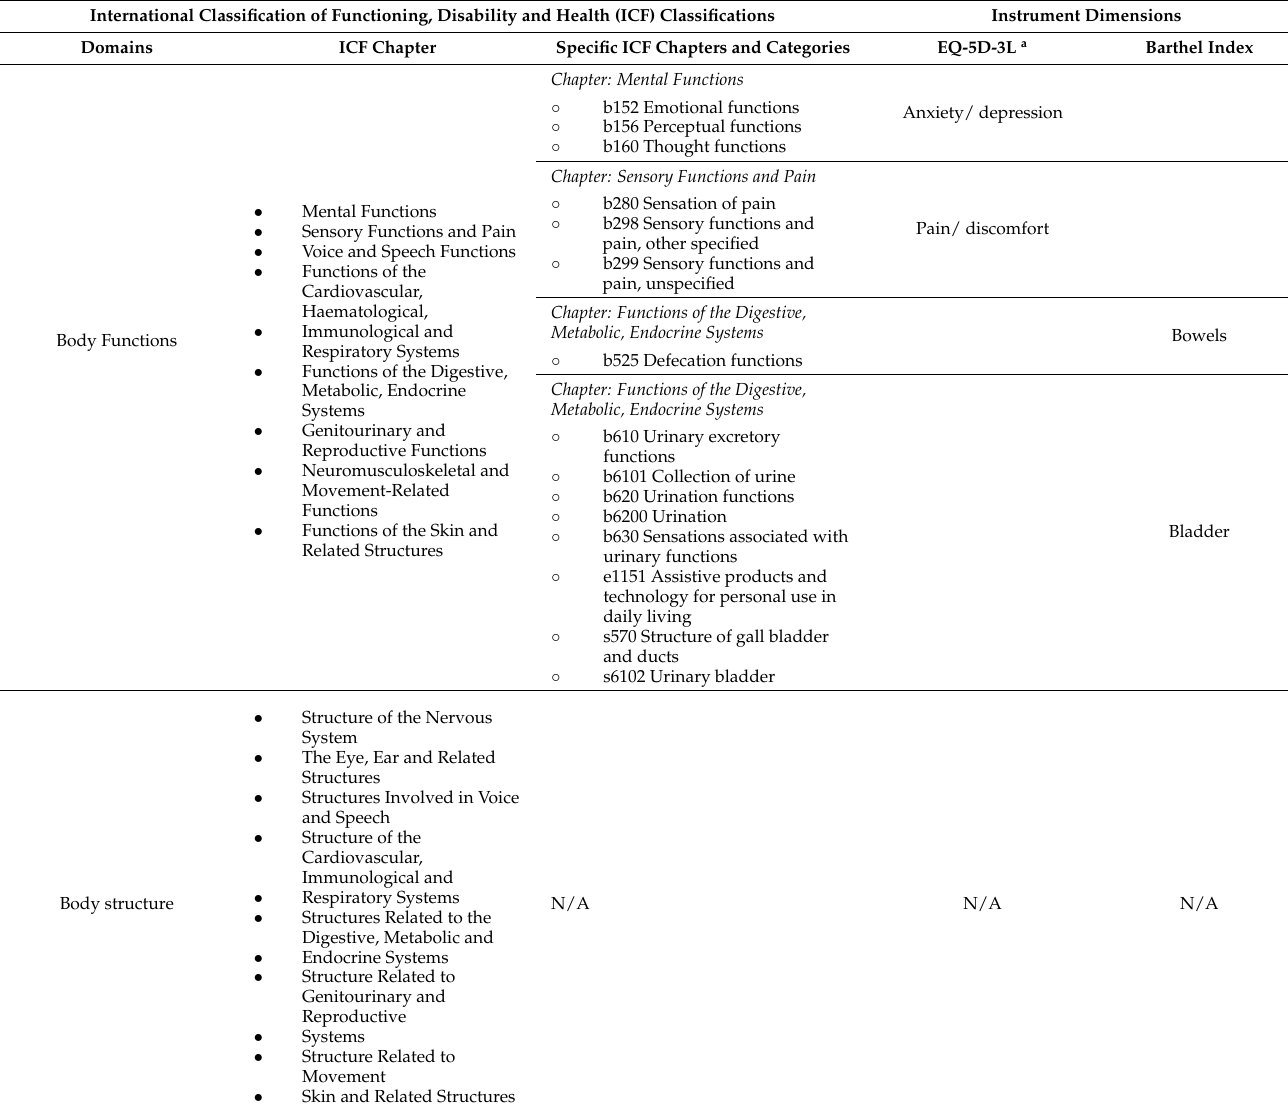
(Table 1). In addition, whereas the EQ-5D-3L and BI questionnaires were completed by staff with or on behalf of their patients, only responses obtained using the former approach were included in this study for the sake of consistency in data collection methods. This study focuses only on respondents who received rehabilitation services and had com- plete data on both the BI and EQ-5D-3L at baseline. All participants provided written informed consent before their inclusion in the study. The Trent Multicentre Research Ethics Committee approved the study. Table 1. Classifying EQ-5D-3L and Barthel Index dimensions according to the International Classification of Functioning, Disability and Health (ICF) classifications a